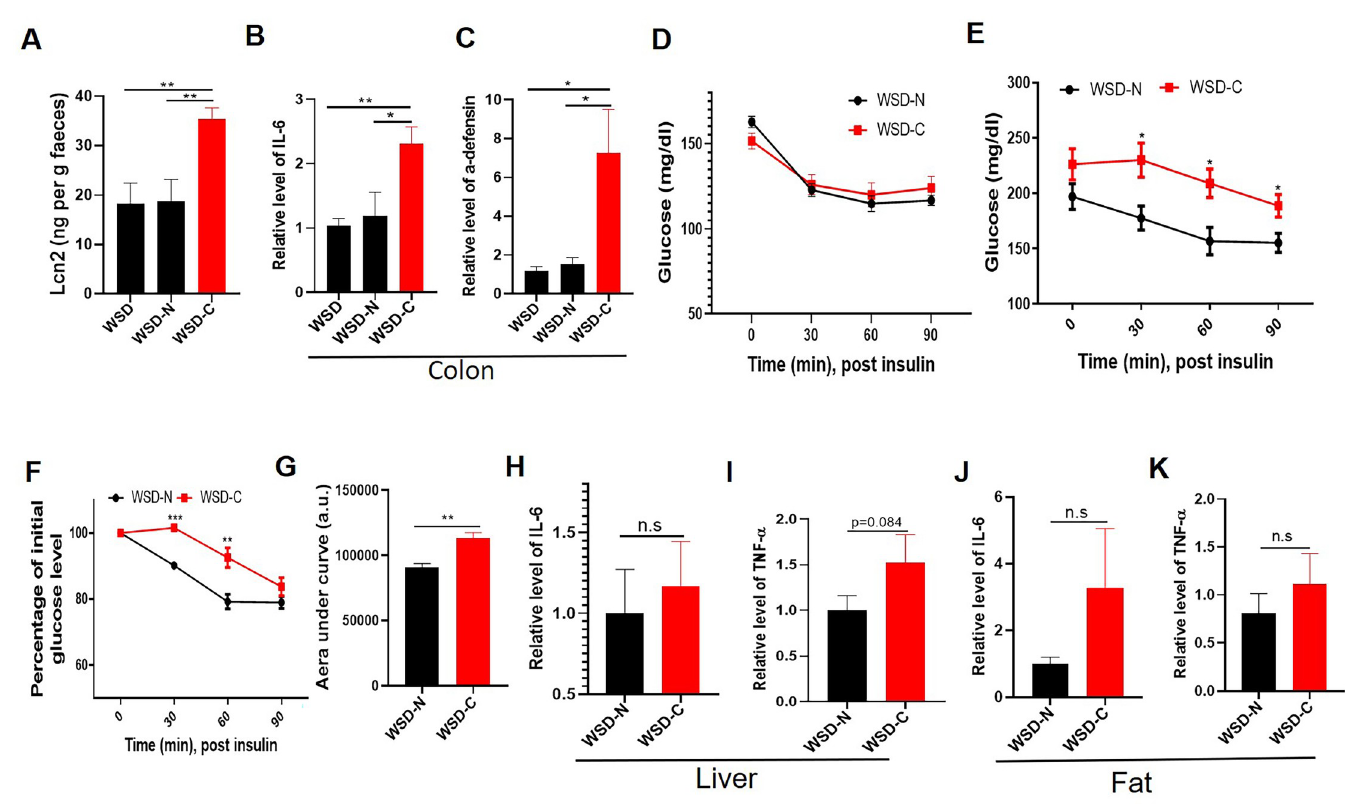
Fig 4. Persistence of Citrobacter infection in WSD-fed mice associates with low-grade inflammation and insulin resistance. A-D. Uninfected WSD-fed mice (WSD) and WSD-fed mice with (WSD-N) or without (WSD-C) C. rodentium clearance were assayed at 42d post- infection for fecal lipocalin 2 (Lcn2) by ELISA (A), colonic expression of IL-6 (B) and α -defensin (C) by qRT-PCR, and glycemic responses to insulin (D). E-K . Five months later, glycemic responses and indices of low-grade systemic inflammation were measured. Measure of absolute (E) and relative (F) glucose levels following insulin as well as area under curve were calculated (G). Relative level of IL-6, TNF- α in liver and epididymal fat were analyzed by qPT-PCR (H-K). Data are the means +/- SEM (n = 5 per group).